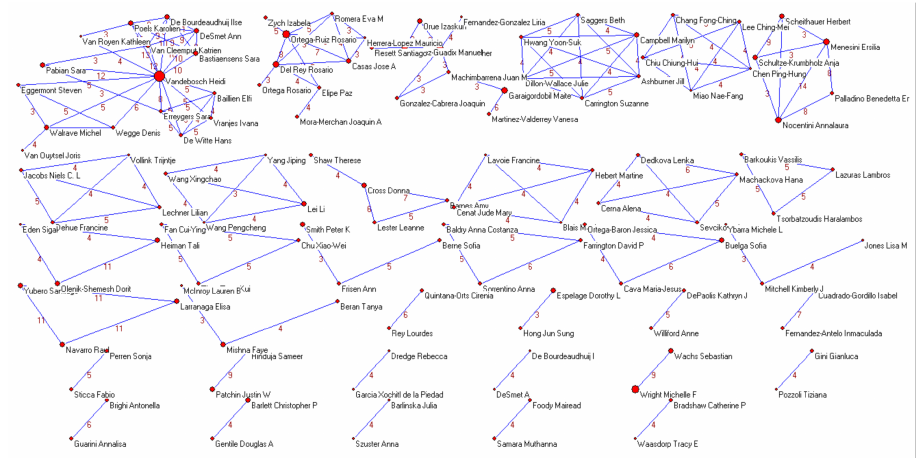
Figure 5. Co-authorship network. Map of collaboration by co-authors.